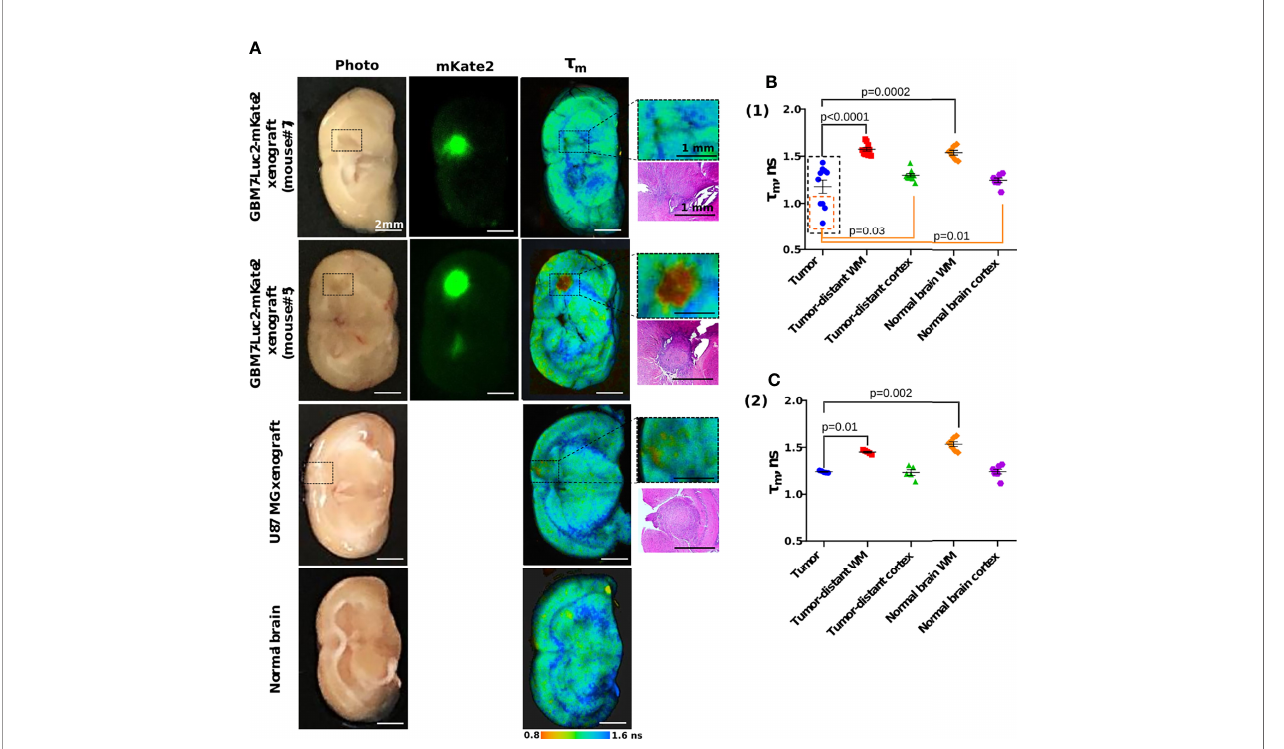
FIGURE 7 | Macro-FLIM of human GBM xenografts and normal brain. (A) Representative auto fl uorescence time-resolved images of GBM7-Luc2-mKate2 xenografts, U87 MG xenograft, and normal mouse brain without tumor. Enlarged regions with a tumor are indicated by the black squares on the lower-magni fi cation panel. The corresponding H&E-stained section is presented under each enlarged region. (B) Quanti fi cation of the mean fl uorescence lifetime tm in the NAD(P)H spectral channel in (1) dual-labeled human GBM xenografts and (2) U87 MG xenografts and normal brain. Scatter dot plot displays the measurements for individual animals (dots) and the mean and SEM (horizontal lines). WM is a white